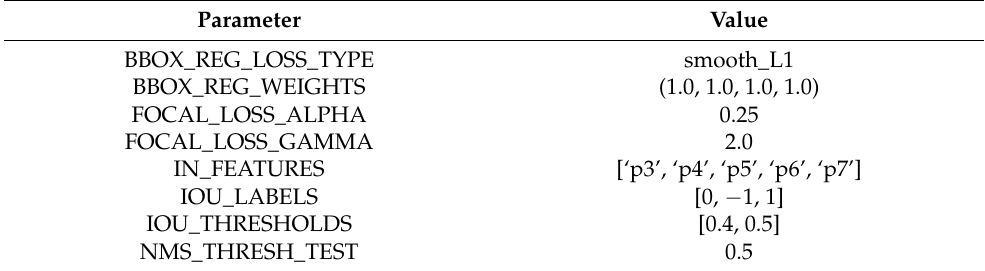
Table 2. RetinaNet training